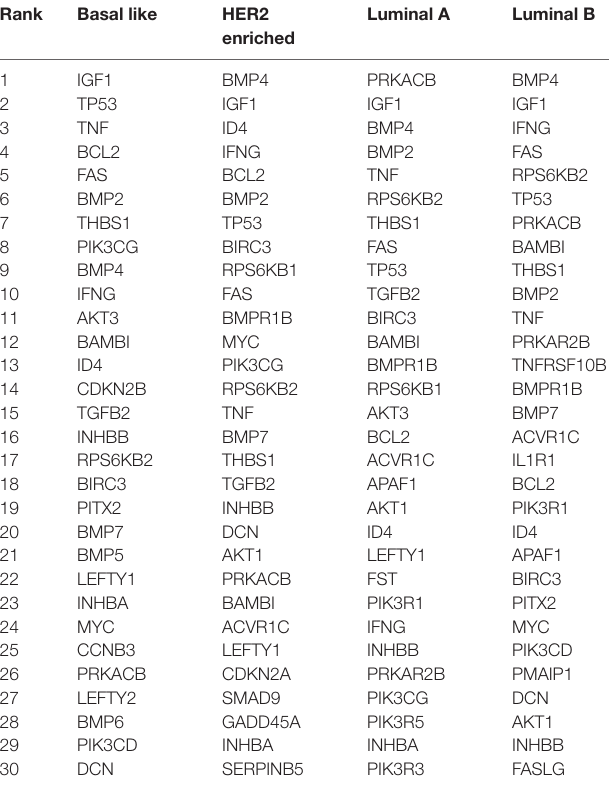
TABLE 2 | Top 30 nodes with the highest degree in four breast cancer